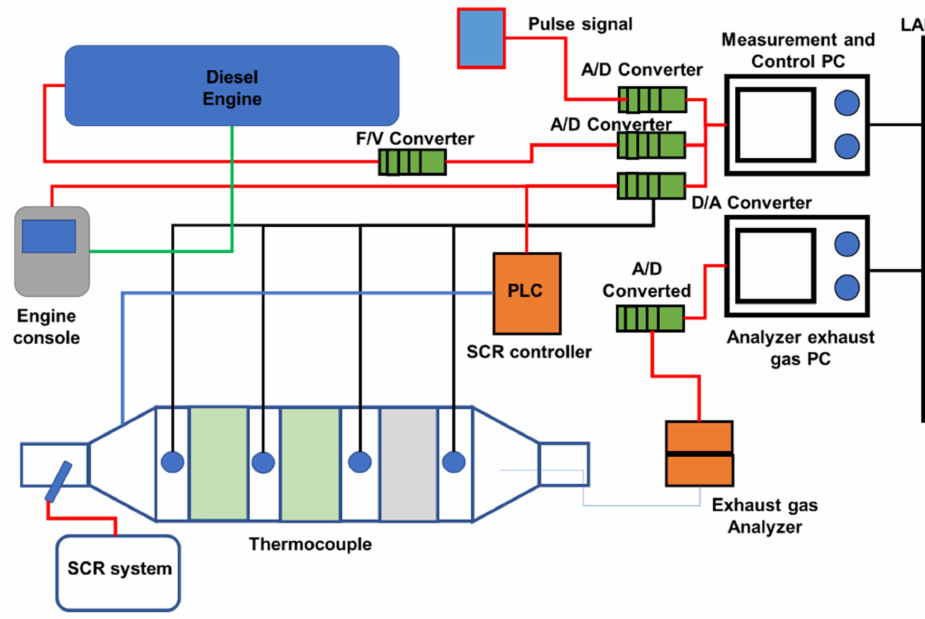
Figure 36. SCR System principle for the marine engine [28]. Table 13. The engine specifications, adapted from Yoichi et al.